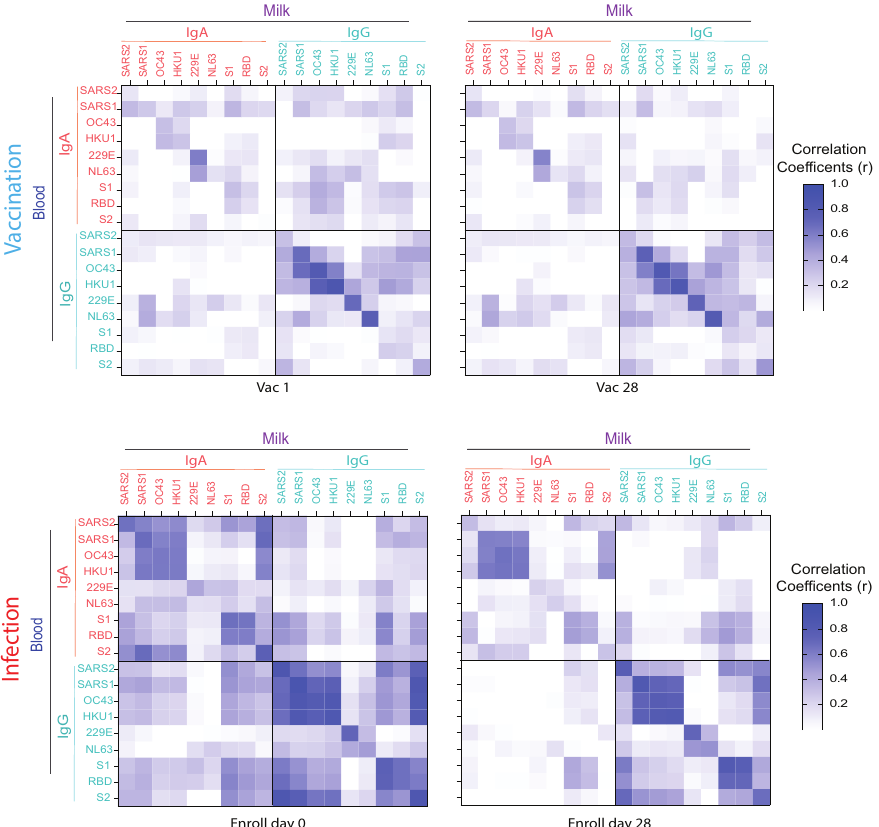
Figure 5. Heatmap of the correlation matrix of antibody responses between milk and blood IgA and IgG against SARS-CoV-2 spike protein (Full-S), S1, S2 and RBD domains, SARS-CoV-1 (SARS1), and HCoVs (OC43, HKU1, 229E, NL63) elicited by vaccination (Vac1 and Vac2) and those that were elicited by acute COVID-19 infection (Day 0 and Day 28). Spearman correlation coefficients (r) between milk and blood immunoglobulins are color coded as indicated in the